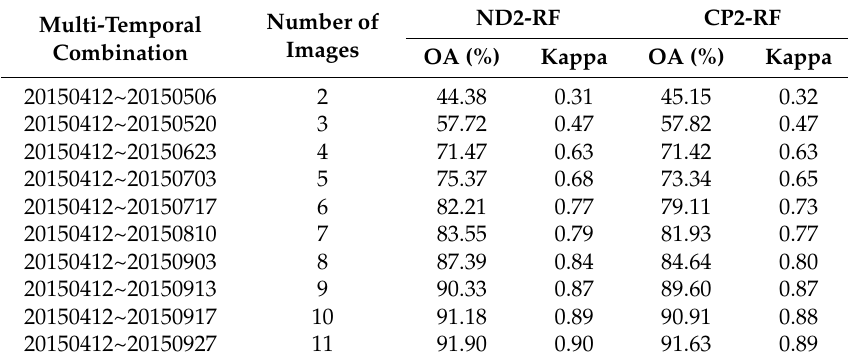
Table 7. The overall accuracy and Kappa coefficient of ND2-RF and CP2-RF classification methods with different combinations of multi-temporal RADARSAT-2